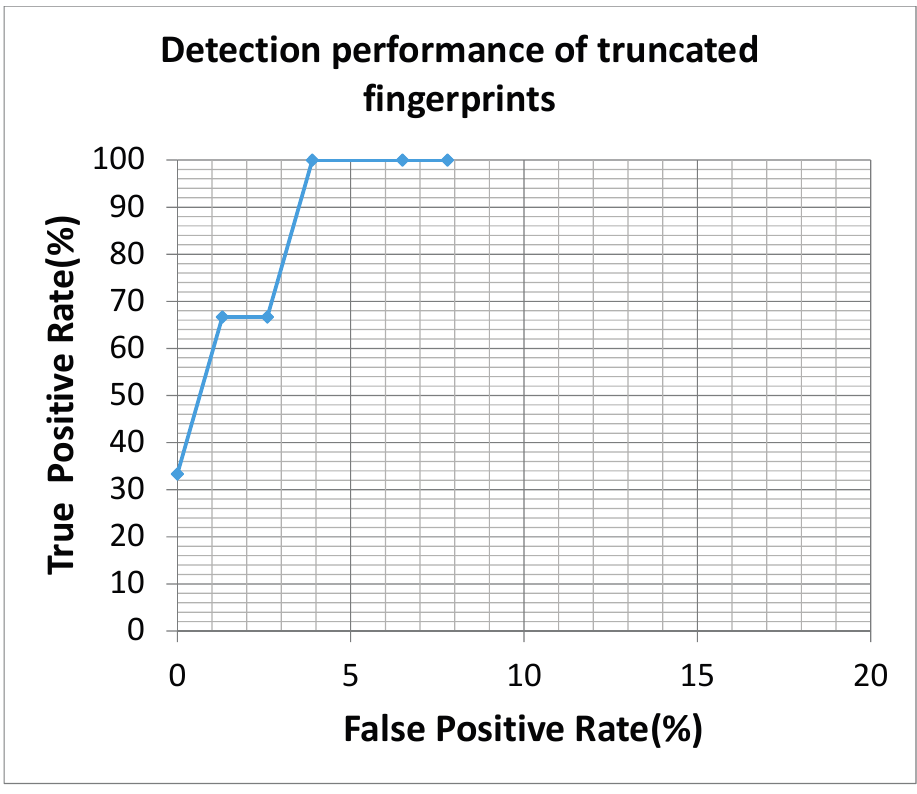
Figure 7. The ROC curve of truncated fingerprint detection is obtained by tuning threshold settings of black-and-white stripe and oriented field change. From left to right, threshold settings were strictly